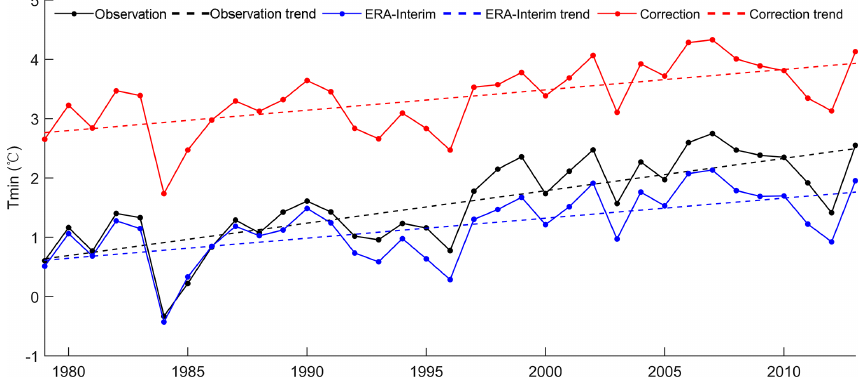
Figure 11. Temporal variations of T min from observation, original ERA-Interim, and correction temperatures for the 24 sites in 1979–2013.